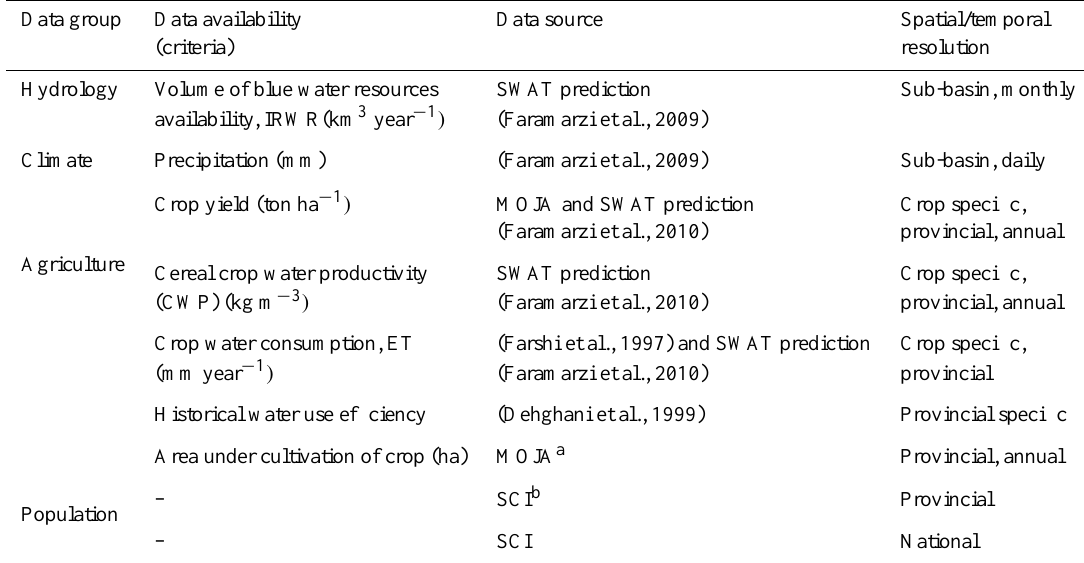
Table 2. List of the data used in this study. Data were available for the period of 1990–2004 except ET and historical water use efficiency which are long-term average (1990–2004) values.